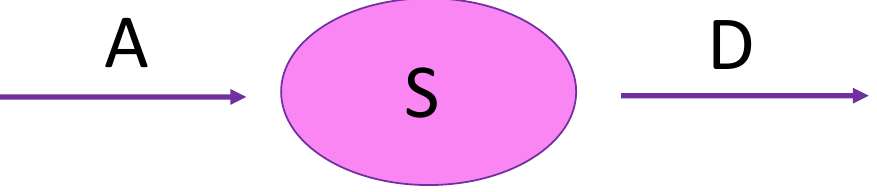
Figure 2. Single server scenario. A: arrival process, S: service process, D: departure